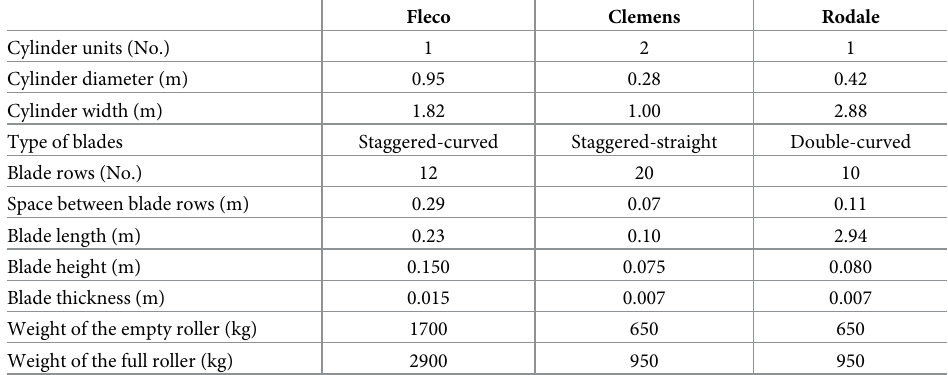
Table 1. Roller crimpers main characteristics.